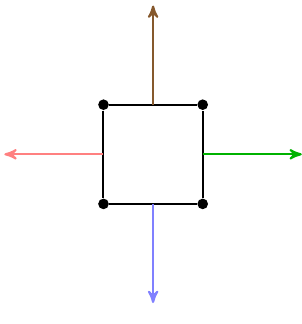
Figure 6a. The toric diagram of the coni- fold C and the vectors orthogonal to the edges.